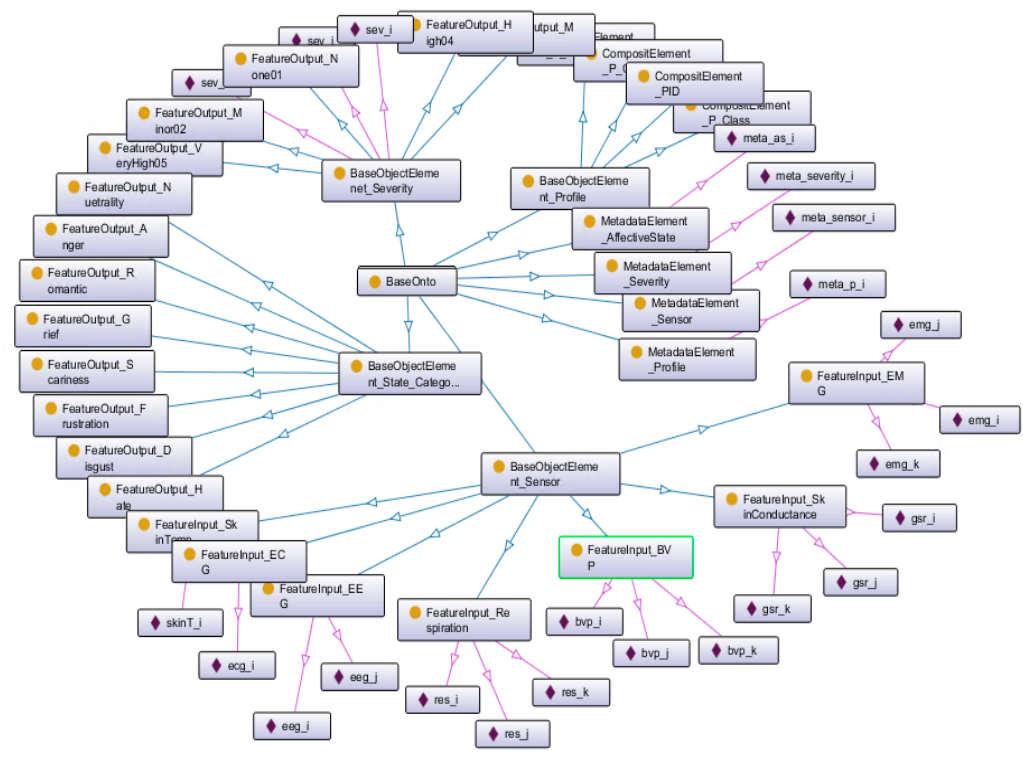
Figure 16. Base semantic ontology model.